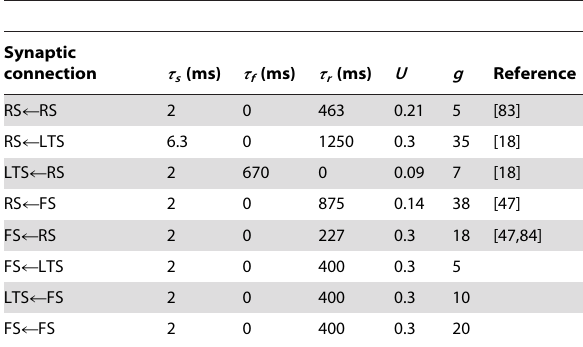
Table 2. Reference parameters for the synapses between the various types of